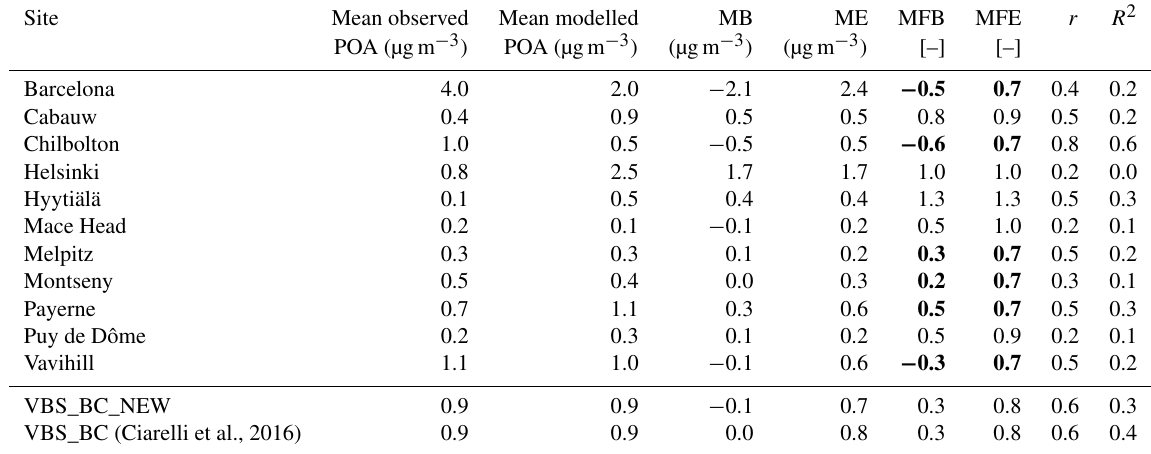
Table 3. Statistics of POA for the VBS_BC_NEW case for February–March 2009 at each AMS site as well as an average of all sites for both VBS_BC_NEW and VBS_BC. Bold numbers represent the stations where model performance criteria were met.